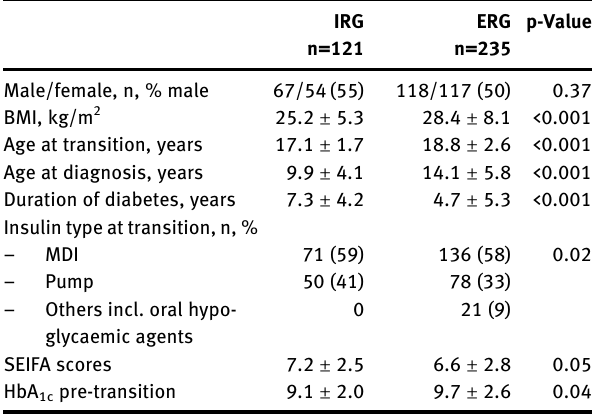
Table  : Patient demographics and insulin type.